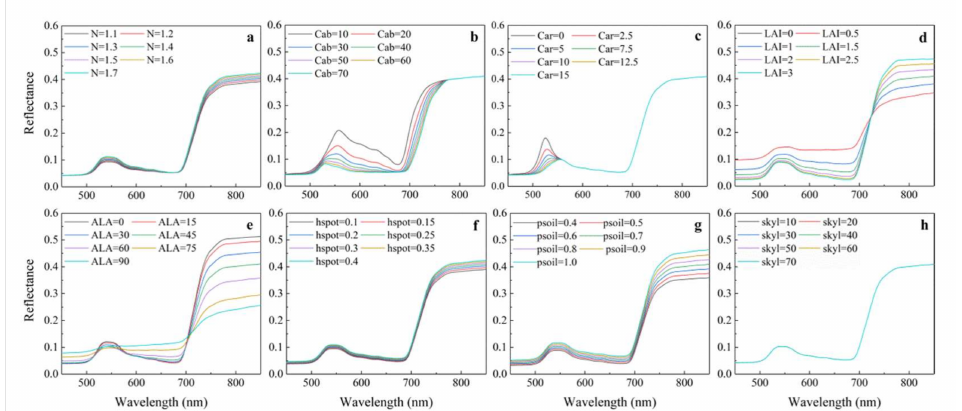
Figure 4. The LSA results of PROSAIL parameters. ( a – h ): the result of N, Cab, Car, LAI, ALA, hspot, psoil and skyl, respectively. Note: N = Structural coefficient; Cab = Total chlorophyll content ( µ g · cm − 2 ); Car = Carotenoid content ( µ g · cm − 2 ); LAI = Leaf area index (m 2 · m − 2 ); ALA = Average leaf angle ( ◦ ); hspot = Hotspot; psoil = Fraction of dry soil; skyl = Fraction of diffuse radiation